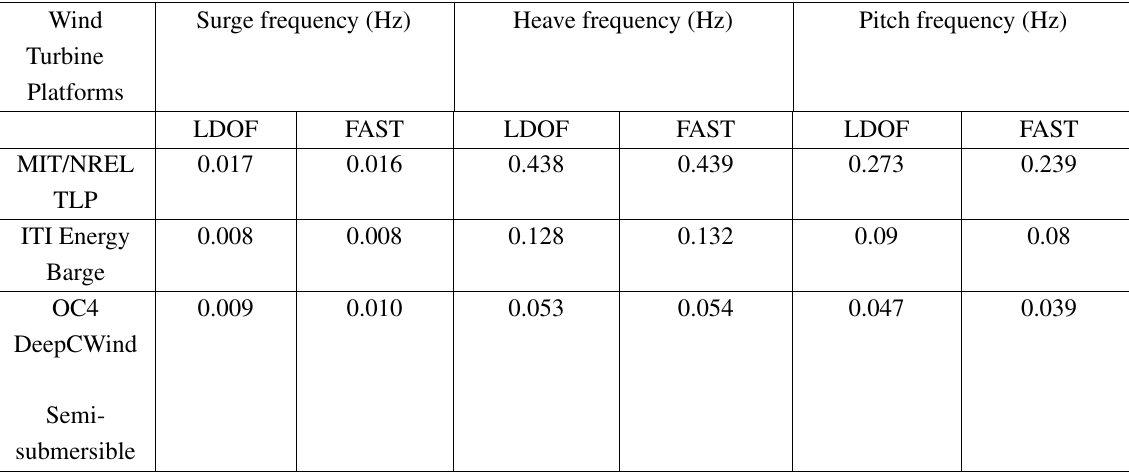
Table 3. Eigenvalue result comparison of three platforms